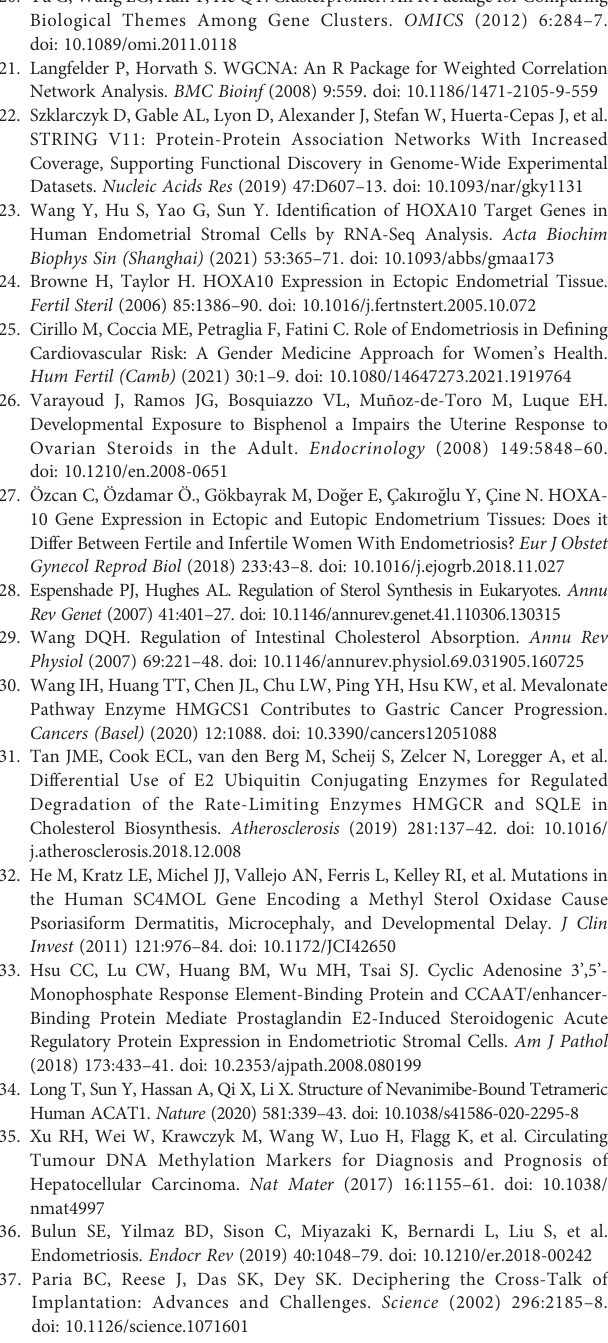
Supplementary Data Sheet 1 | The fl ow cytometry data and gating strategies. Supplementary Data Sheet 2 | The R